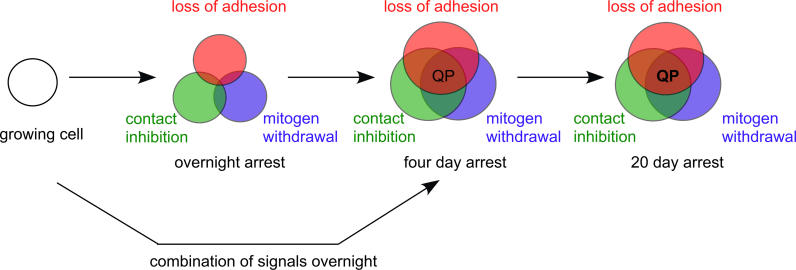
Summary of the Relationships among Quiescent StatesIn cells arrested overnight by a specific arrest signal, gene expression changes are largely signal-specific with a small amount of overlap. When cells have been arrested for 4 d, there continue to be signal-specific changes, but now there are a large number of commonly regulated genes that we refer to as a “quiescence program.” In cells arrested for 20 d, the intensity of the changes in the quiescence program are magnified. The three circles are intended to reflect the enhancement of the quiescence program at 20 d. We have not analyzed all the three arrest conditions at this late time point. When cells are arrested by a combination of extracellular signals, quiescence program gene expression changes appear after only an overnight arrest.